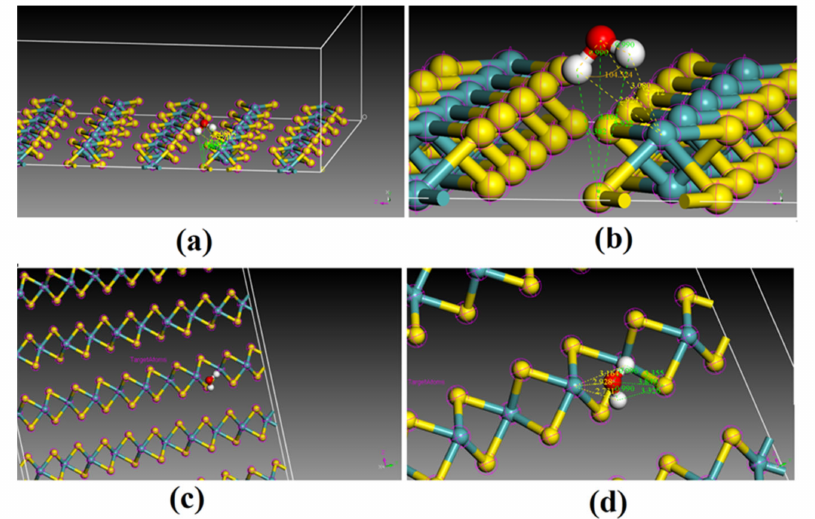
Figure 9. Geometry of the two most stable adsorption sites for H 2 O at the (110) surface: ( a , b ): 110-G1; ( c , d ): 110-G2 (yellow ball represents sulfur atom; blue ball represents molybdenum